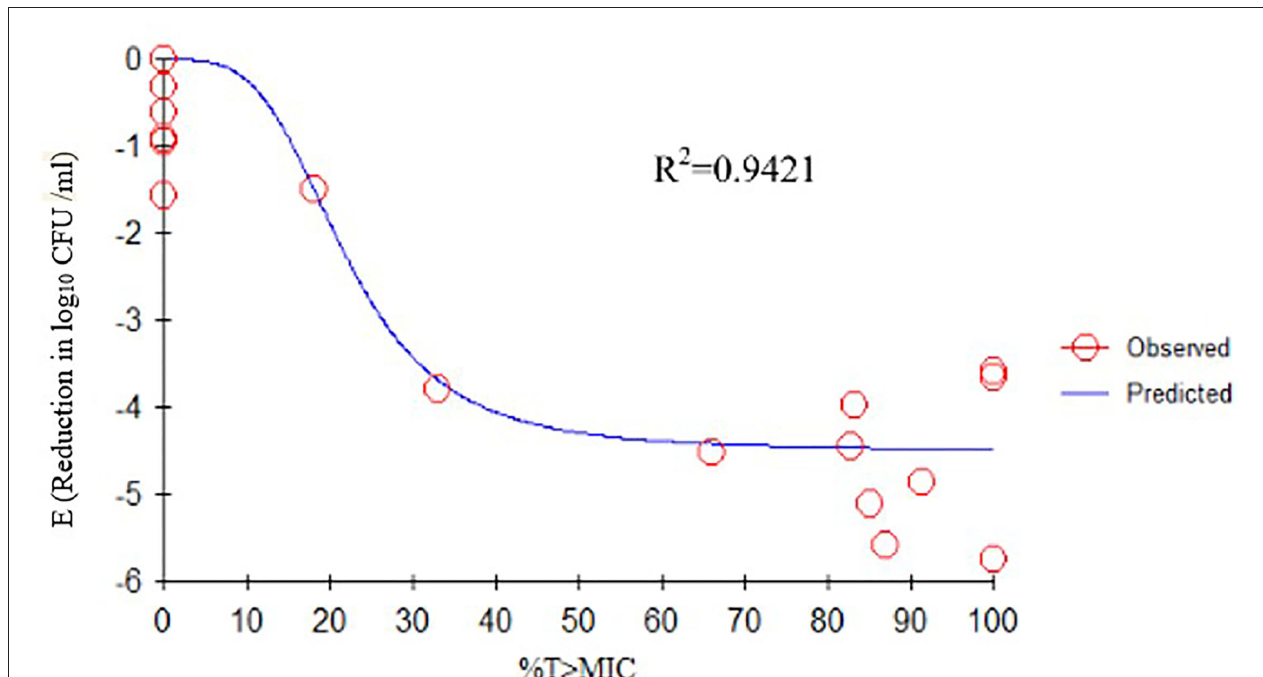
FIGURE 2 | In vivo antibacterial activity of tulathromycin against Actinobacillus pleuropneumoniae CVCC259 at different concentrations.